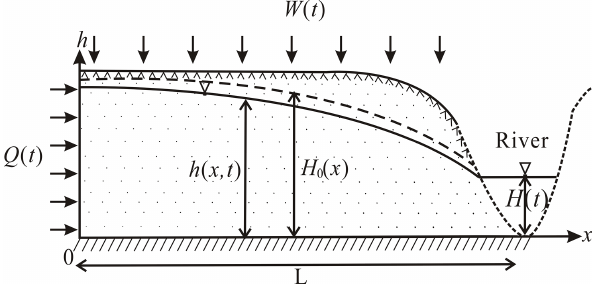
Figure 1. A schematic of the unconfined aquifer studied, where W(t) is the random time-dependent source/sink, H 0 (x) is the ran- dom initial condition, Q(t) is the random time-dependent flux at the left boundary, H(t) is the random time-dependent water level at the right boundary, L is the distance from the left to the right boundary, and h(x , t ) is the random groundwater level in the